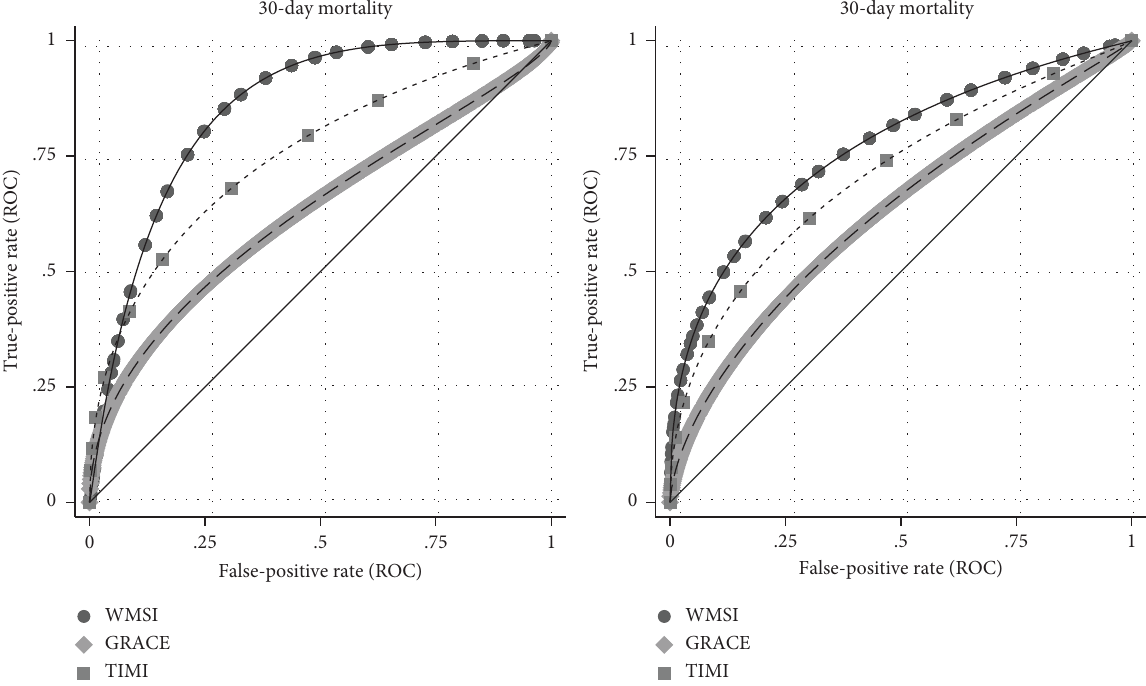
Figure 4: Comparison of receiver operator curves for 30-day and 12-month all-cause mortality by WMSI, GRACE and TIMI risk scores demonstrating higher AUC for WMSI compared to either traditional STEMI risk score. WMSI–Wall motion score index, AUC–Area under curve, STEMI–ST-segment elevation myocardial